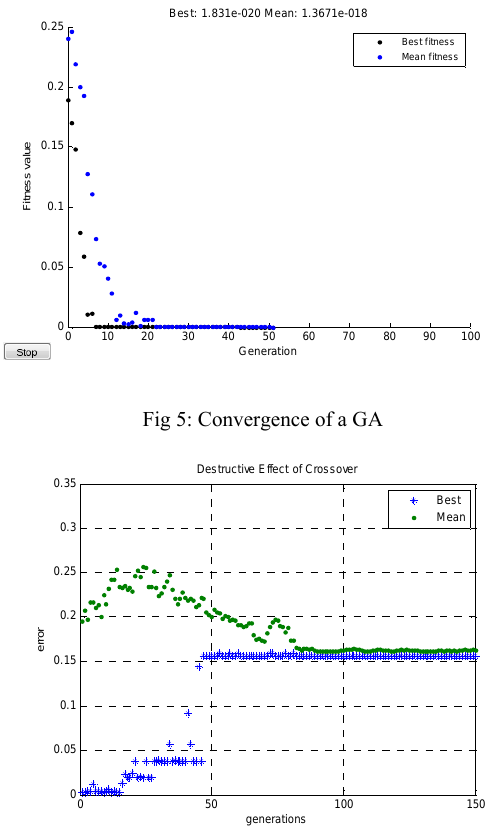
Fig. 6: Destructive effect of improper crossover operator